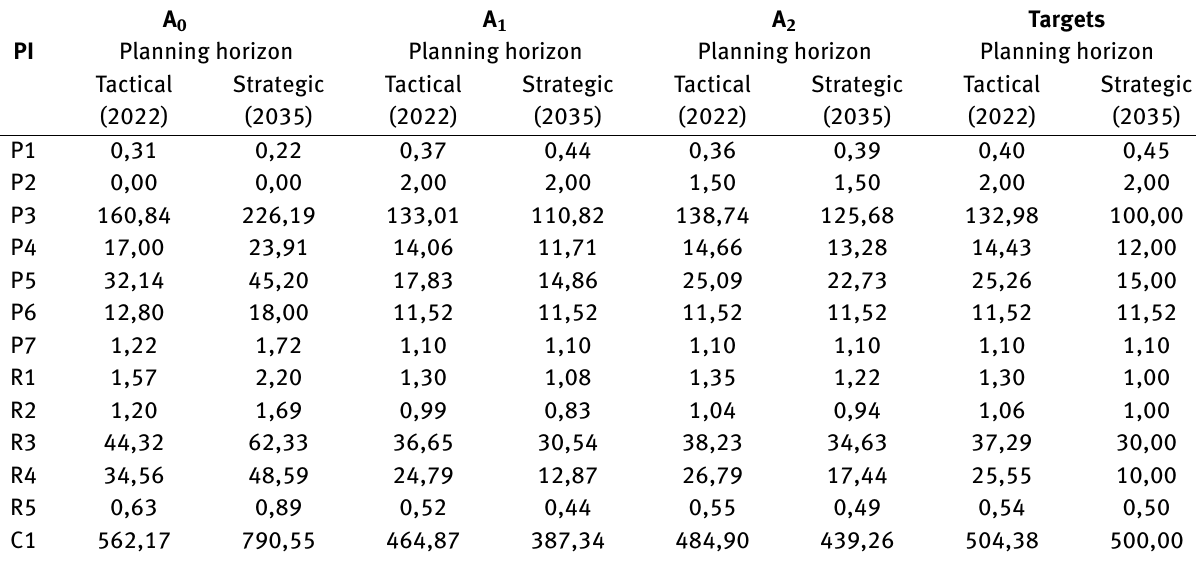
Table 2: Assessment of the three alternatives for the tactical and strategic planning horizon